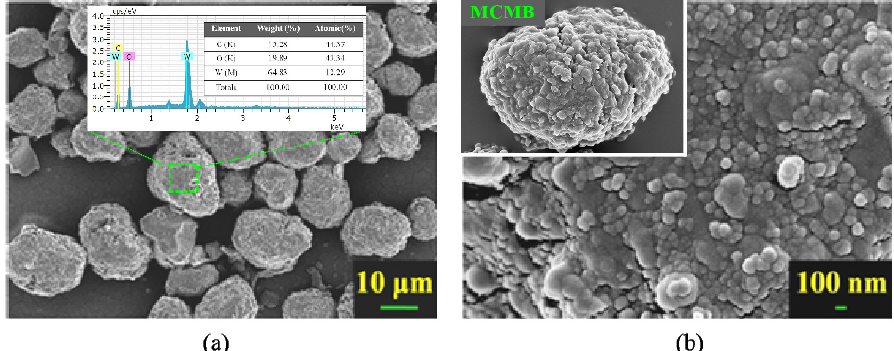
Figure 4. SEM morphologies and EDS of the WO 3 thin films deposited on the carbon electrode: ( a ) the magnification of 1000× ( b ) the magnification of 30,000×.